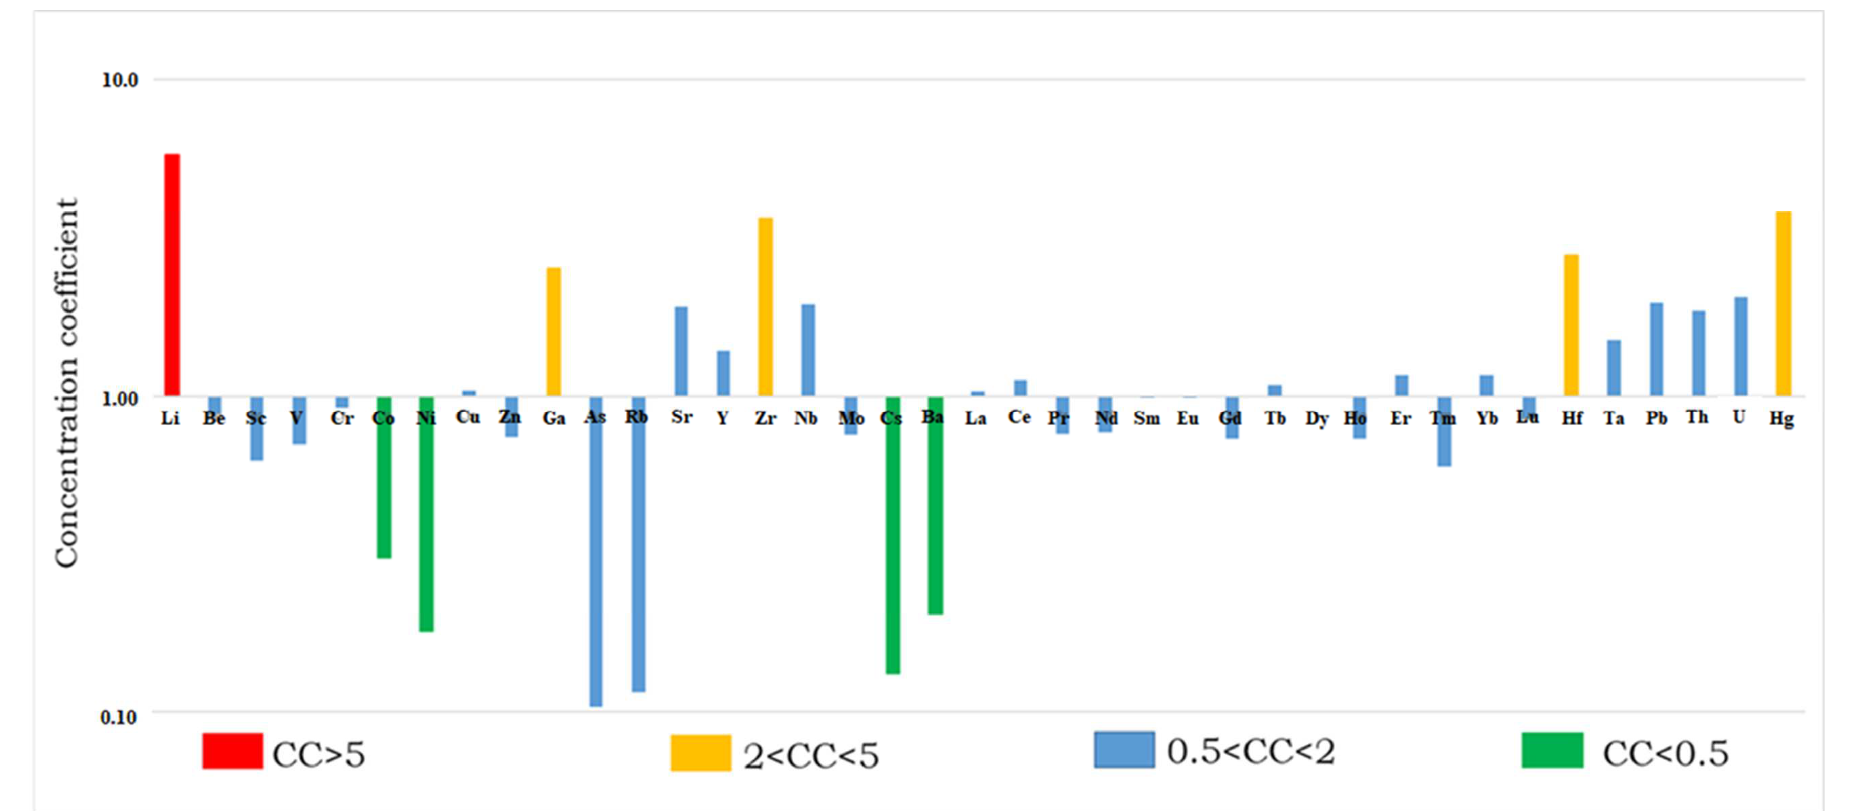
Figure 5. The concentration coefficients (CCs) of the trace elements and REY in the Anjialing coal samples.